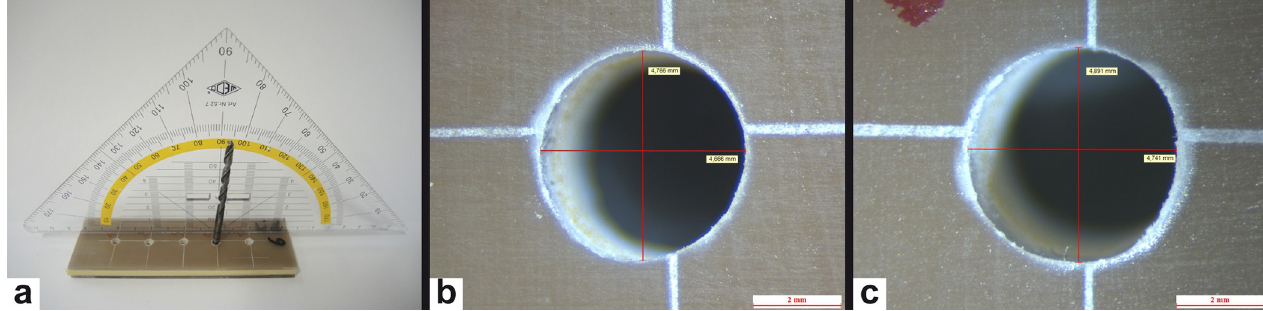
Fig 2. Resulting boreholes. (A) Measuring angle deviation with the help of a set square (B) Typical borehole electric drilling (C) Typical borehole manual drilling.